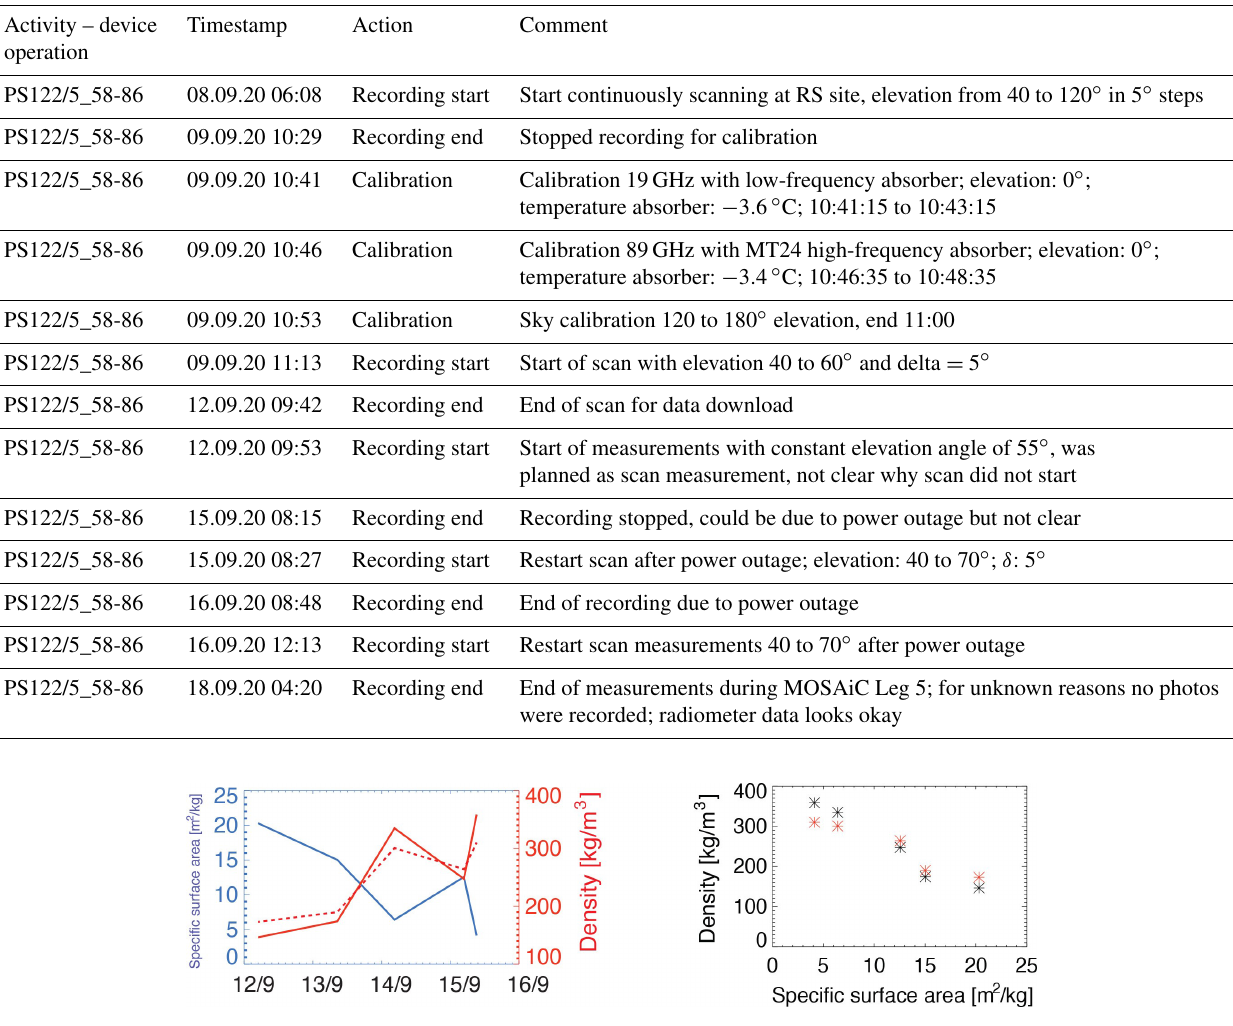
Table A2. List of measurement periods of the surface-based radiometer (SBR) during Leg 5. Note that no data were recorded between